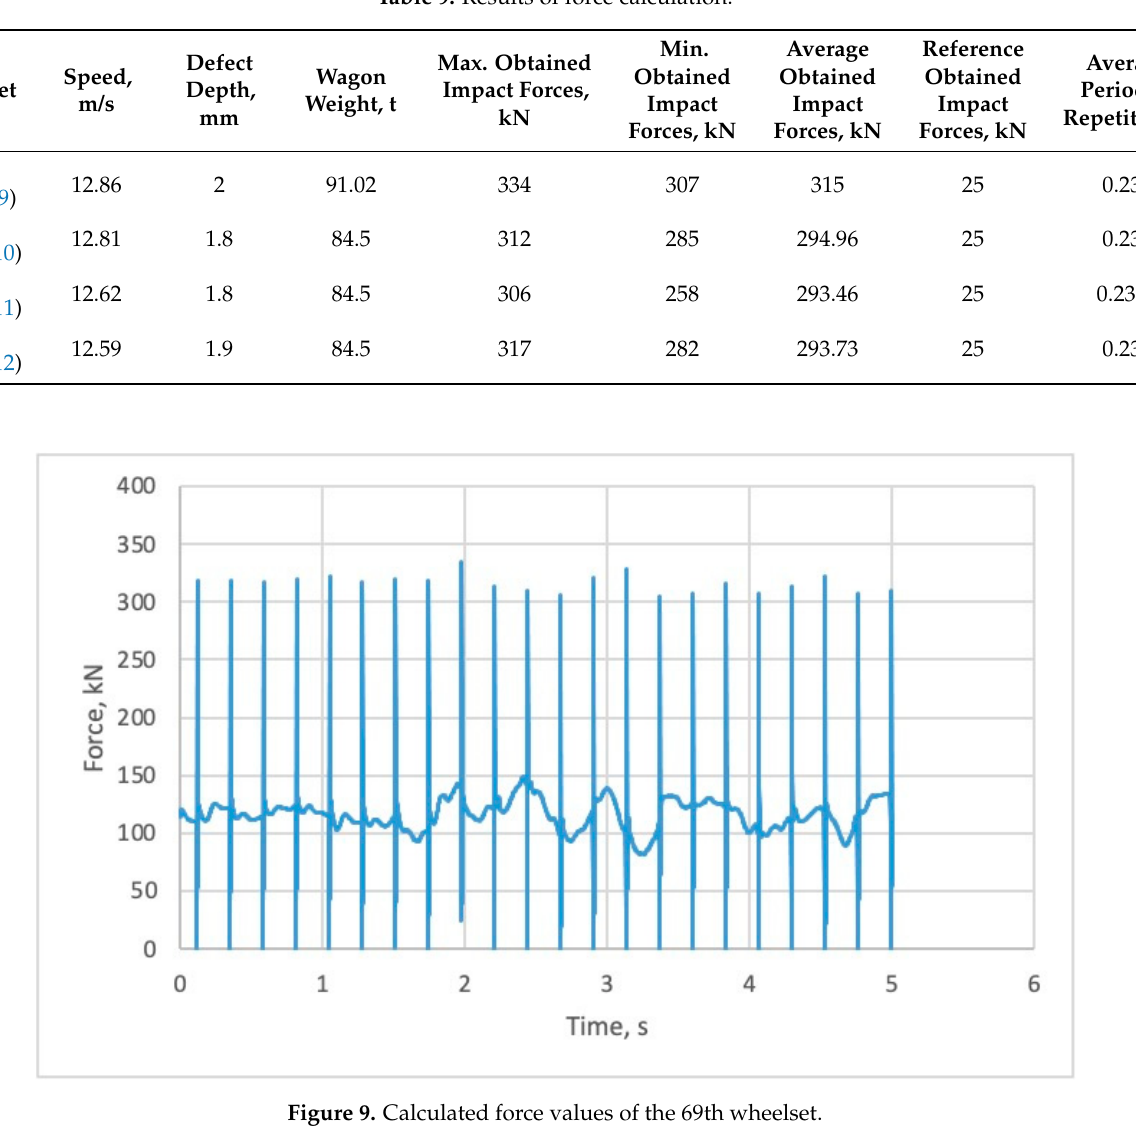
Table 9. Results of force calculation.